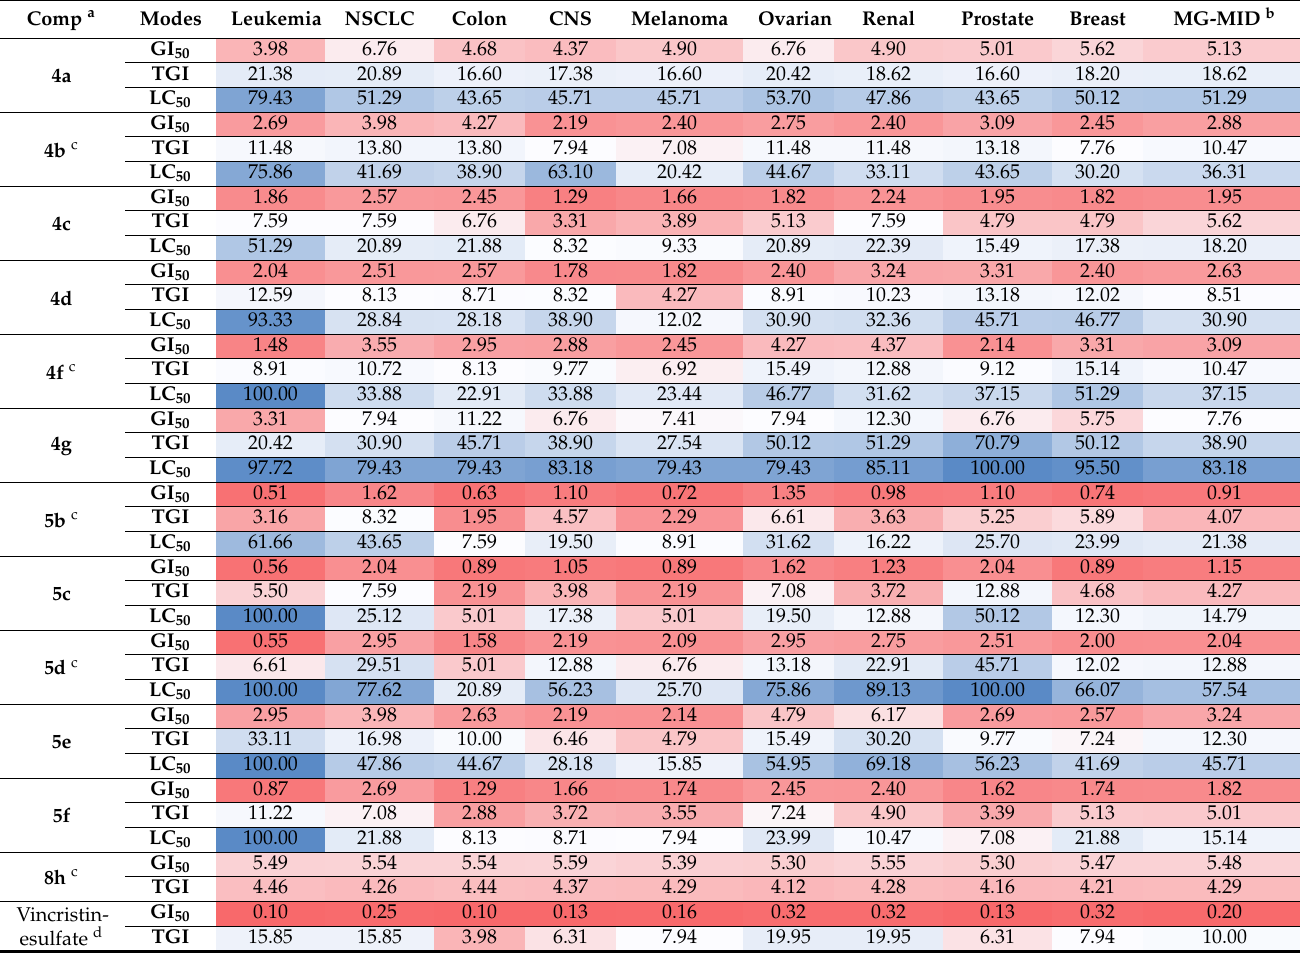
Table 1. Nine subpanels at five concentrations: growth inhibition, cytostatic and cytotoxic activity ( µ M) of the selected